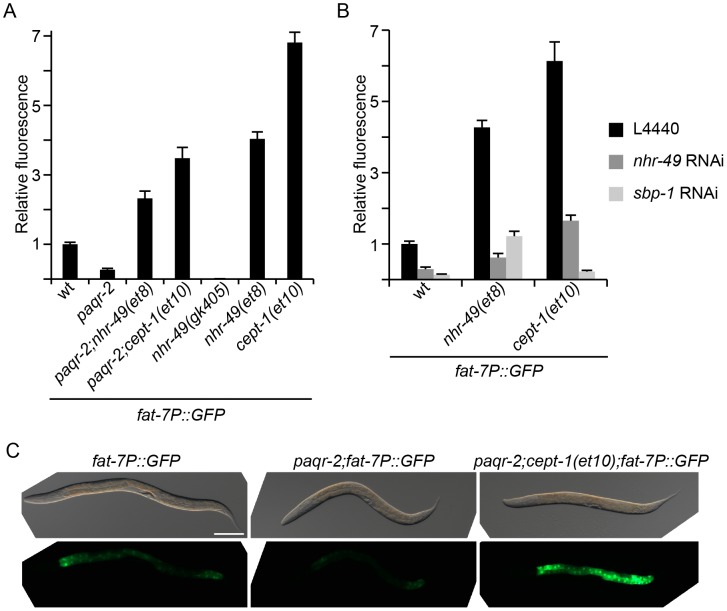
The fat-7 desaturase is regulated by paqr-2 and its suppressors.(A) The paqr-2 mutant has decreased expression of fat-7, while strains carrying the paqr-2 suppressors nhr-49(et8) or cept-1(et10) show a marked increase in fat-7 expression when compared to control worms (wt). (B) The nhr-49(et8) and cept-1(et10) alleles are dependent on both nhr-49 and sbp-1 for the upregulation of fat-7. (C) Representative images of worms from panel (A). Note the strong GFP signal in the paqr-2;cept-1(et10) double mutant, especially compared to the low levels of the paqr-2 single mutant. Scale bar is 100 µm. All strains in this figure carry the fat-7 promoter GFP reporter in integrated form.